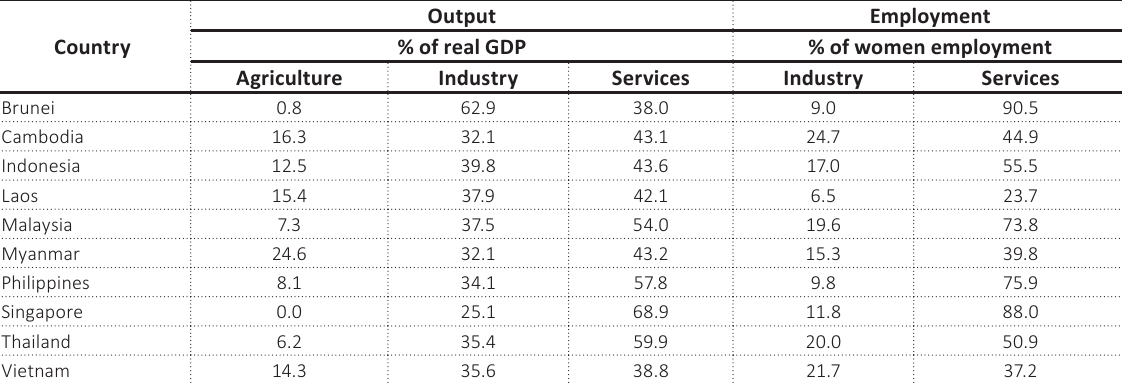
Source: Menon et al.